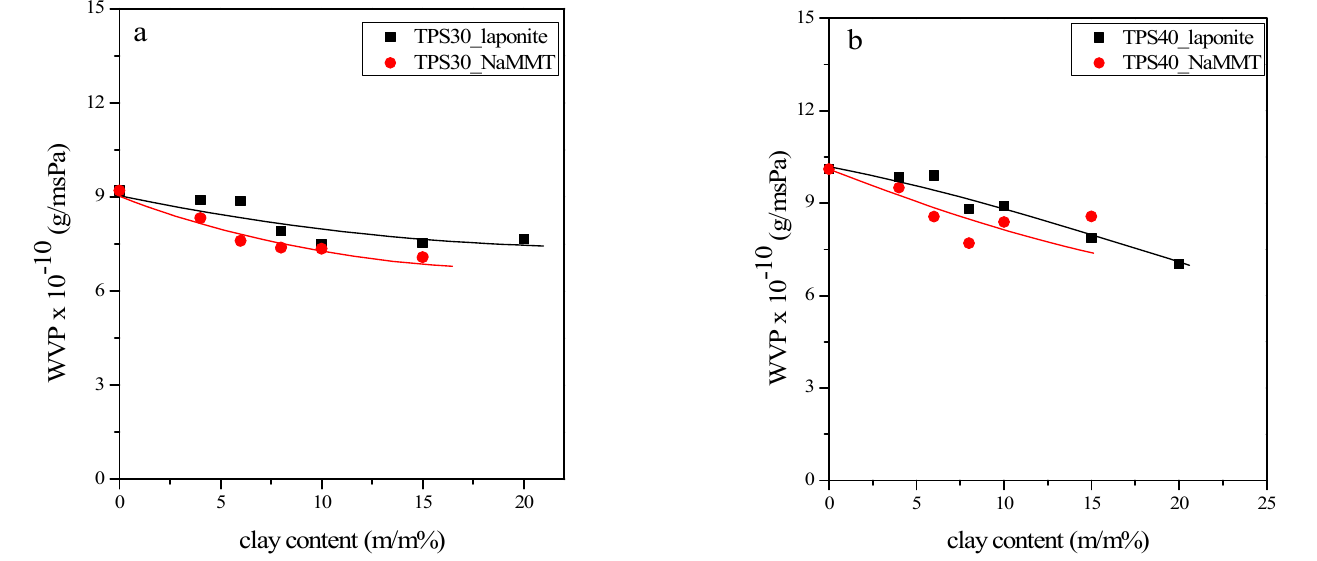
Figure 9. Dependence of water vapor permeability on clay content in TPS30 ( a ) and TPS40 ( b ) nano ‐ composites.